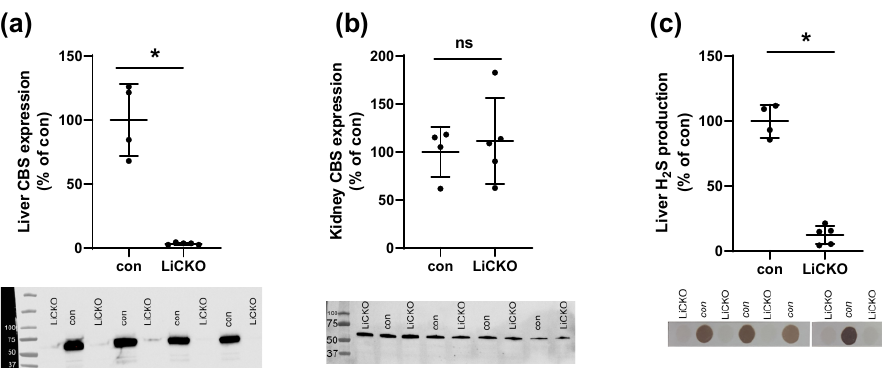
Figure 1. CBS is selectively deleted in liver. ( a ) CBS protein expression in LiCKO is significantly downregulated in liver; ( b ) CBS protein expression in LiCKO is unaffected in kidneys; ( c ) Down- regulation of CBS in liver is associated with impaired hydrogen sulfide production. * p < 0.05.